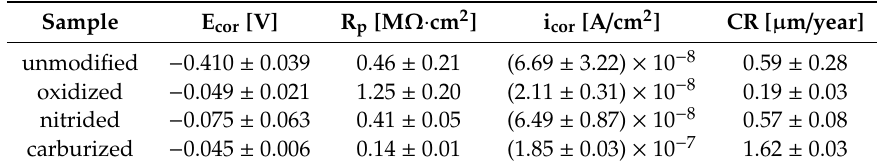
Table 1. Corrosion parameters of Ti-6Al-4V alloy after di ff erent thermo-chemical treatments (given as mean values ± standard deviation, n =